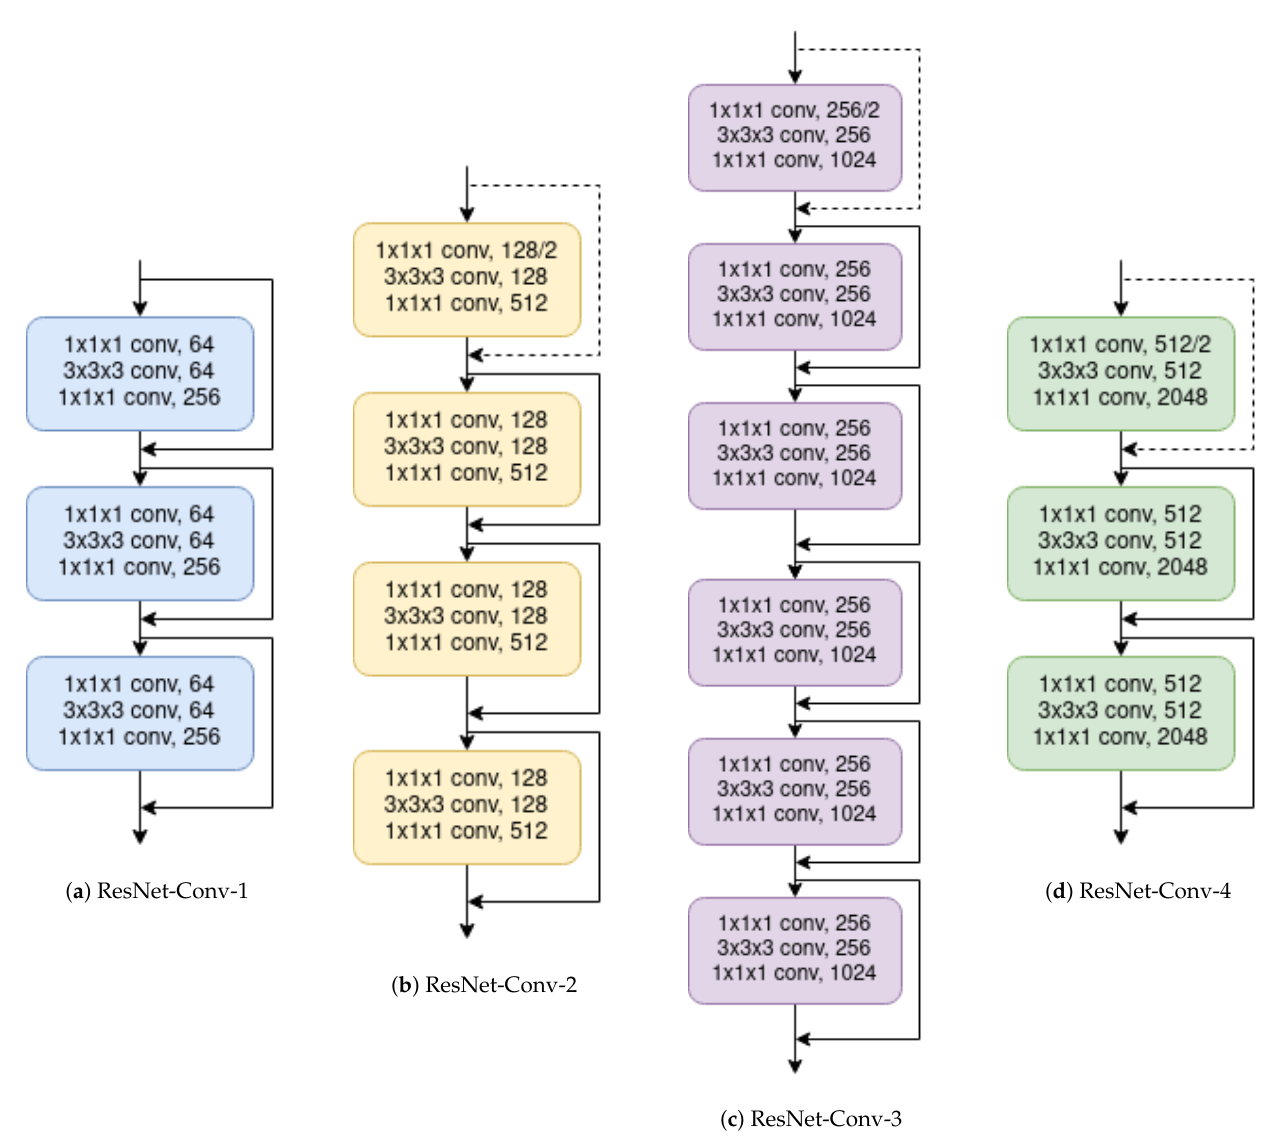
Figure 7. Building blocks of the Resnet50. Table 1. Architectures of